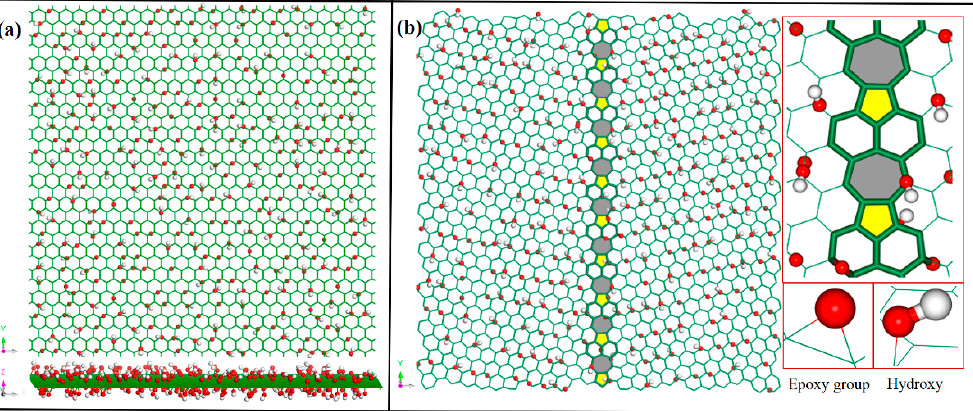
Figure 1. ( a ) Graphene oxide (GO) model; ( b ) polycrystalline graphene oxide (PGO) model (carbon atoms and carbon– carbon bonds are shown in green, oxygen atoms in red, and hydrogen atoms in white).